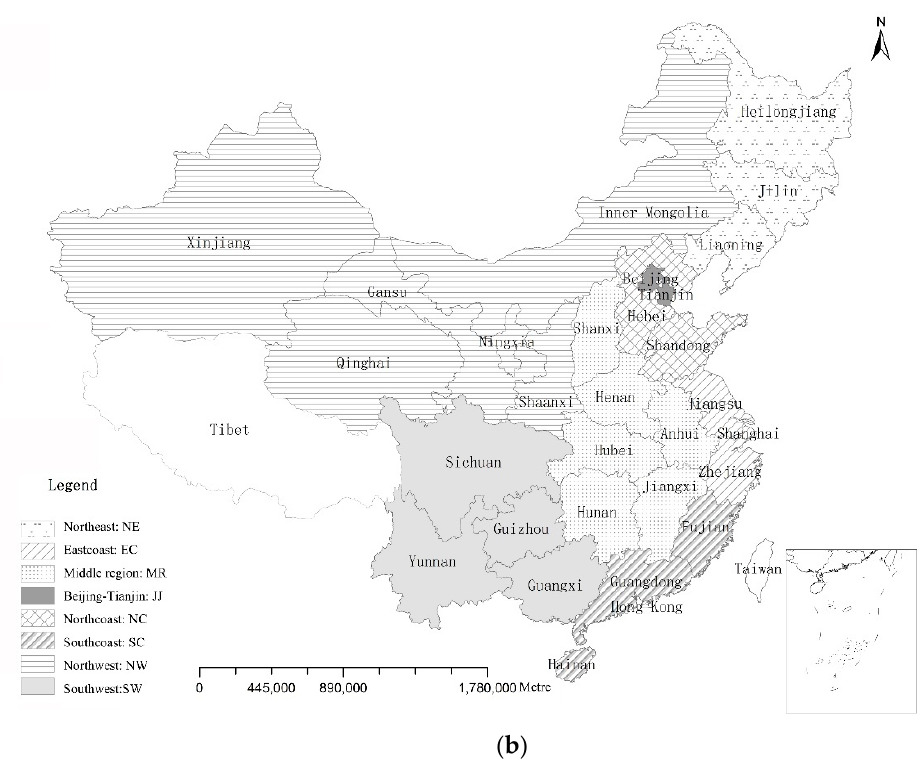
Figure 1. Research area. ( a ) 30 provinces studied, ( b ) 8 subnational